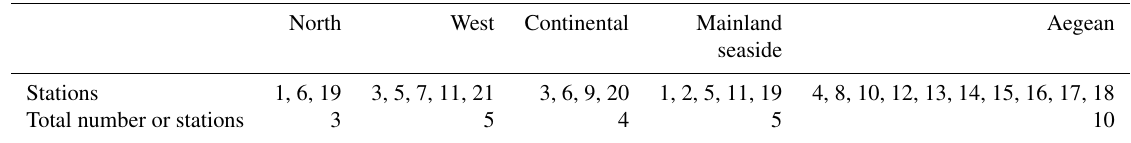
Table A2. HNMS stations